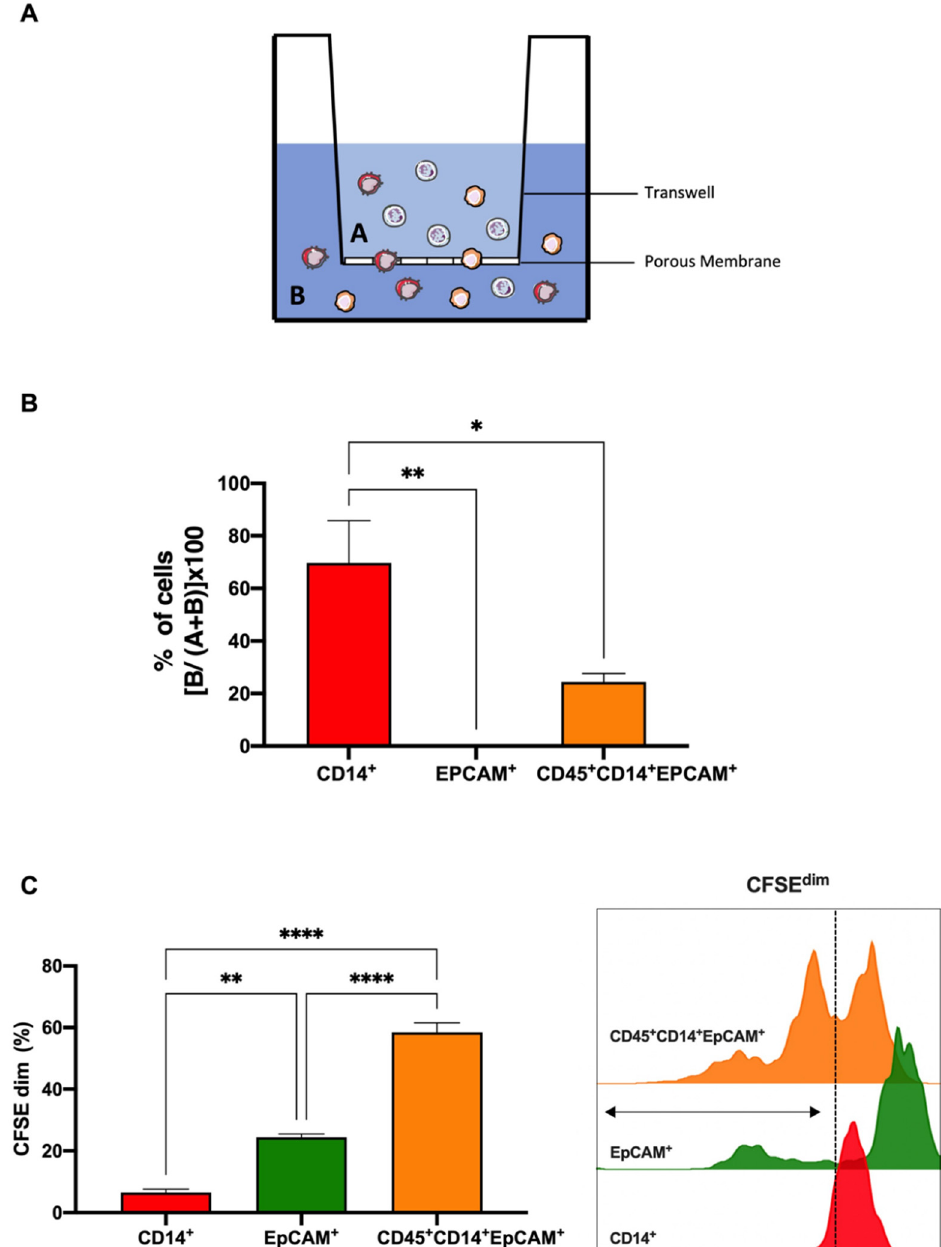
Figure 4. THCs display enhanced migratory and proliferative abilities. ( A ) Schematic representation of the migration assay (8 µ m transwell pores). Cells resulting from the fusion assay were put on the top chamber ( A ) then migrating cells were quantified in the bottom chamber ( B ) by FACS. ( B ) Percentages of migration, % of cells [ B /( A + B )] × 100, of the CD14+ human monocytes (red), EpCAM+ SW620CSCs (green) and CD45 + CD14 + EpCAM + THCs (tangerine) from the transwell assay are shown (n = 4). ( C ) Left: percentage of proliferation measured as CFSE dilution (CFSEdim) of CD14 + human monocytes (red), EpCAM + SW620CSCs (green) and CD14 + EpCAM + THCs after 5 days (n = 4). Right: representative histograms of CD14 + human monocytes (red), EpCAM + SW620CSCs (green) and CD45 + CD14 + EpCAM + THCs proliferation after 5 days. *, p < 0.05; **, p < 0.01; and ****, p < 0.0001 in ordinary one-way ANOVA with Tukey’s multiple comparison post-hoc